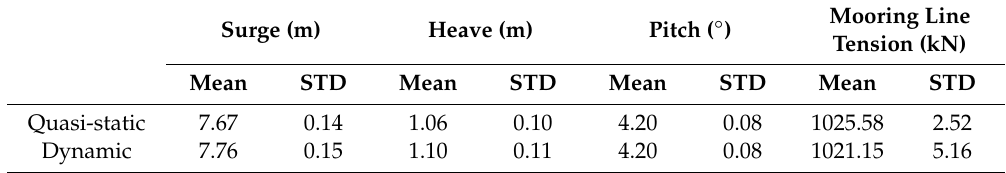
Table 8. Comparison of dynamic analysis of mooring lines for the LC3 case.